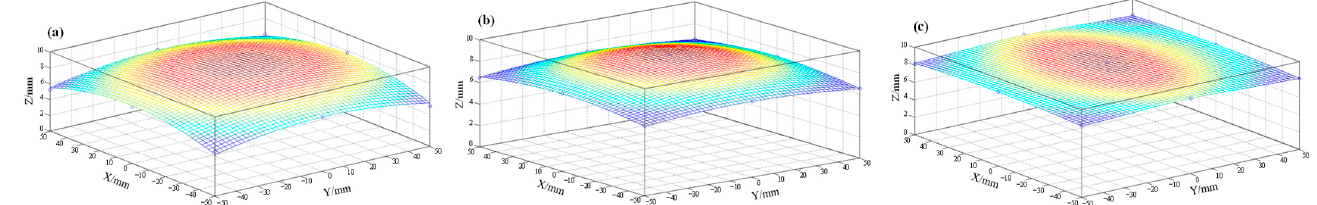
Table 2. Efflux time of resin through each outlet.